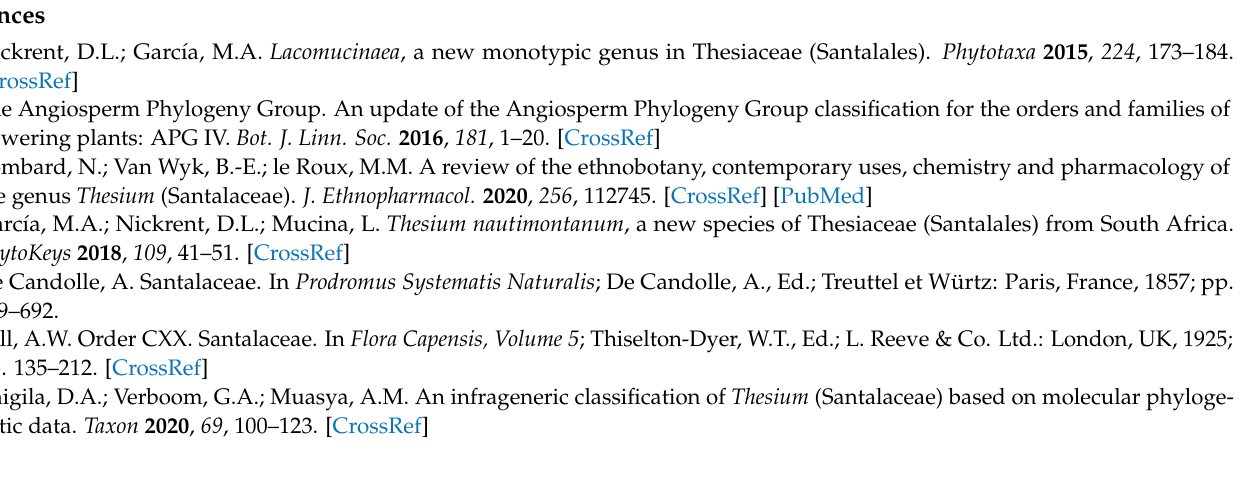
cant contributors indicated. Supplementary Figure S5. Heatmap of the main phenolic peaks detected in the extracts of 128 samples, representing 46 Thesium species, as well as sister genera Osyridicarpos and Lacomucinaea